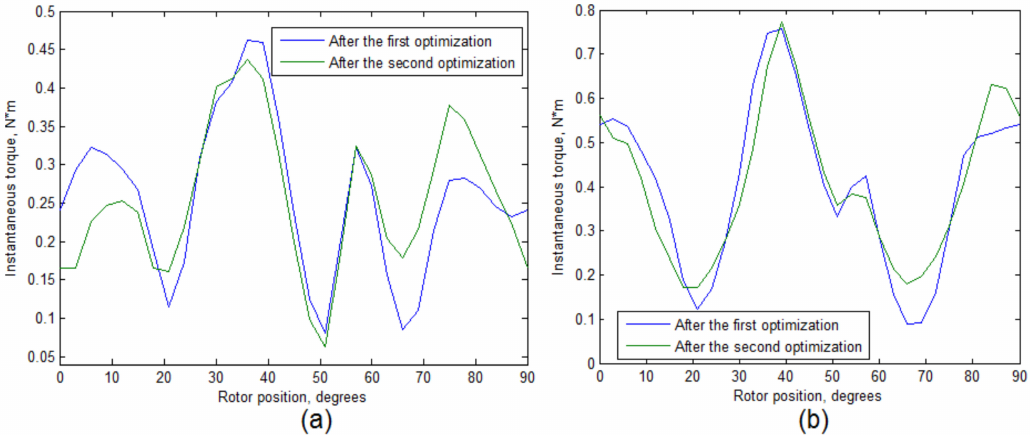
Figure 14. Change of the motor torque oscillations during the second optimization.